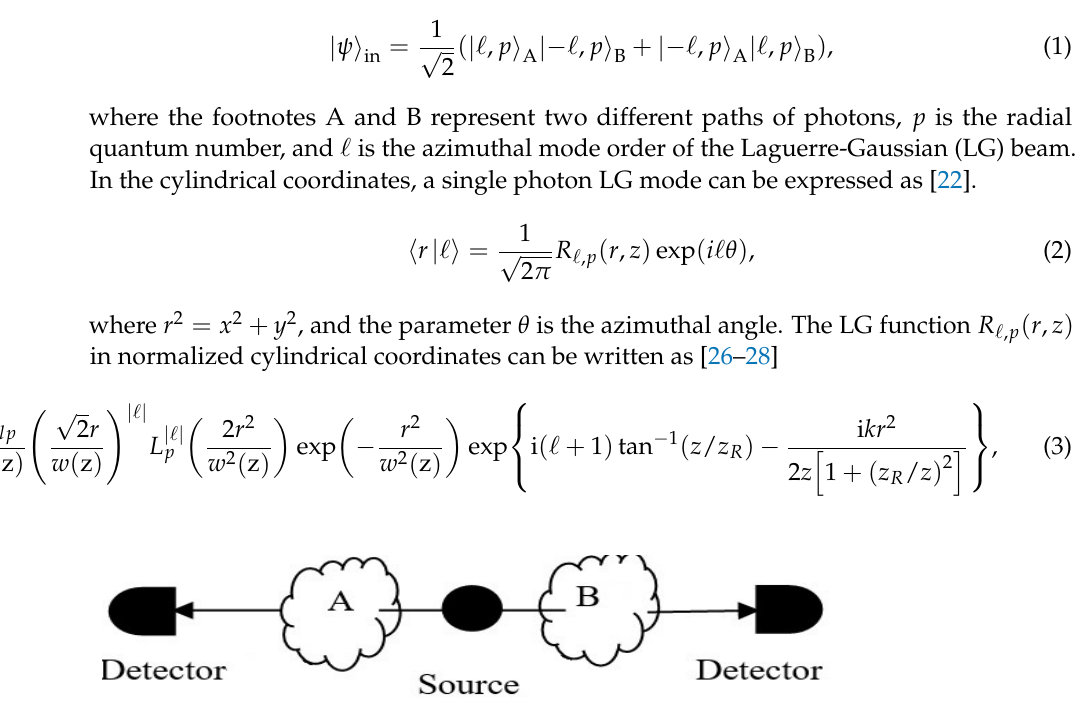
Figure 1. Sketch of the setup. A pair of entangled photons are generated by a source, and propagate along two weakly turbulent atmospheres which is labeled by A and B toward two detectors.